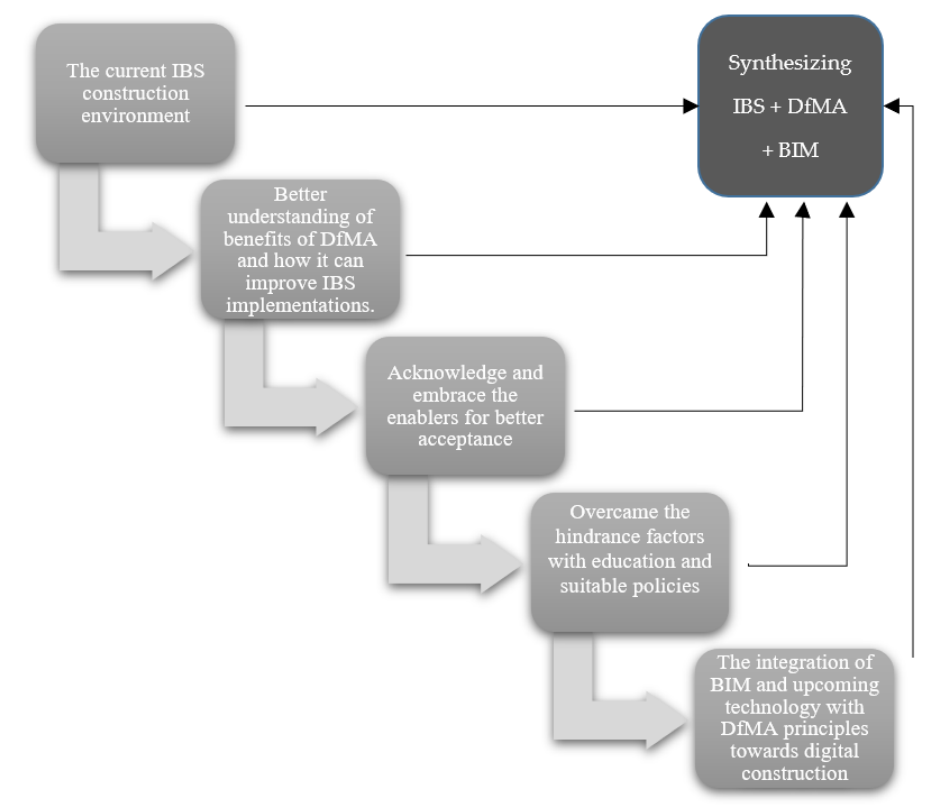
Figure 5. Synthesising DfMA principles with IBS and BIM.